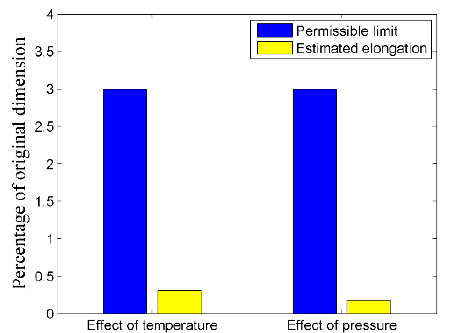
Figure 8. Comparison of PE 100 enclosure’s longitudinal deformations regarding temperature and pressure with their respective allowable limits.